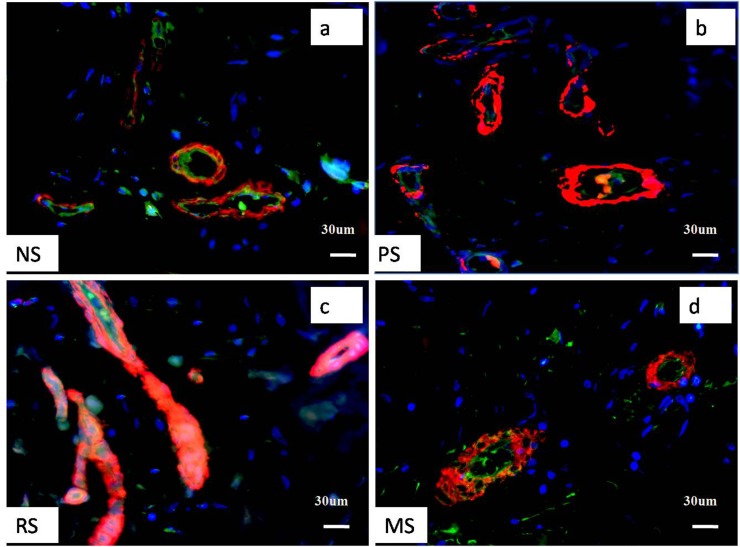
Pathological changes in hypertrophic scar tissue at different stages were shown by immunofluorescence staining for CD31 and α-SMA.Although few microvessels and fibroblasts were observed in NS, more were observed in PSs; however, most of the microvessels were partially or completely occluded in RSs, and the RSs exhibited fewer fibroblasts. In MSs, the numbers of microvessels and cells were comparable to those in NS. a, b, c, and d represent NS, PS, RS and MS samples, respectively. Scale bar: 30 μm. The green staining represents ECs, the red staining represents smooth muscle cells, and the blue staining represents fibroblasts.